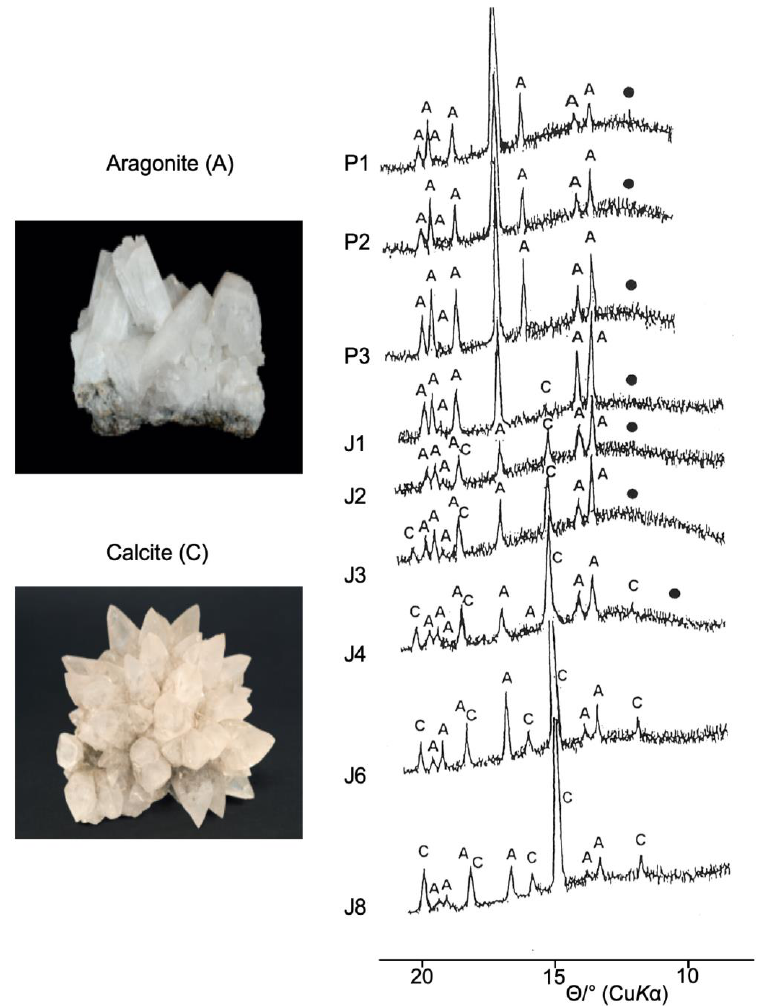
Figure 4. Characteristic parts of diffraction patterns of selected samples of Ostrea edulis of different development stages, P1–J8 (see Figure 5); C—calcite; A—aragonite [21].